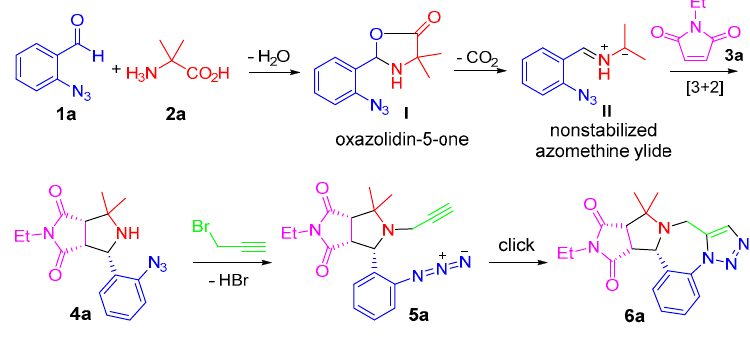
Supplementary Materials: The following are available online. 1 H-NMR, 13 C-NMR, and 19 F-NMR spectra of final